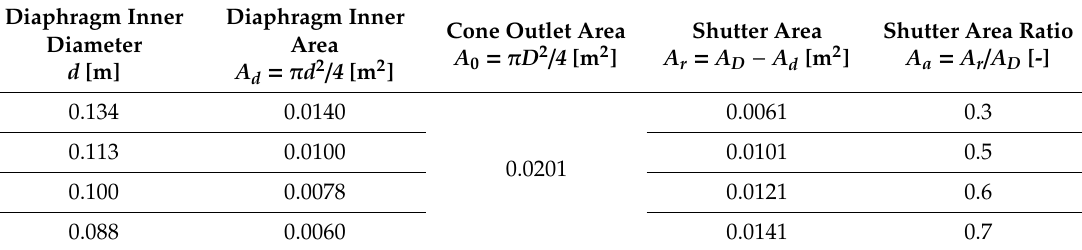
Table 1. Data for all investigated diaphragm openings.